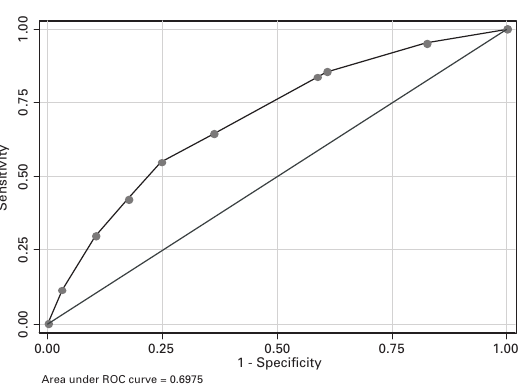
the ROC curve of 0.76 with a Se of 74% (65–82), Sp of 69% (59–78), PPV of 72% (62–80) and NPV of 71% (61–80) (see figure 2). When we replaced